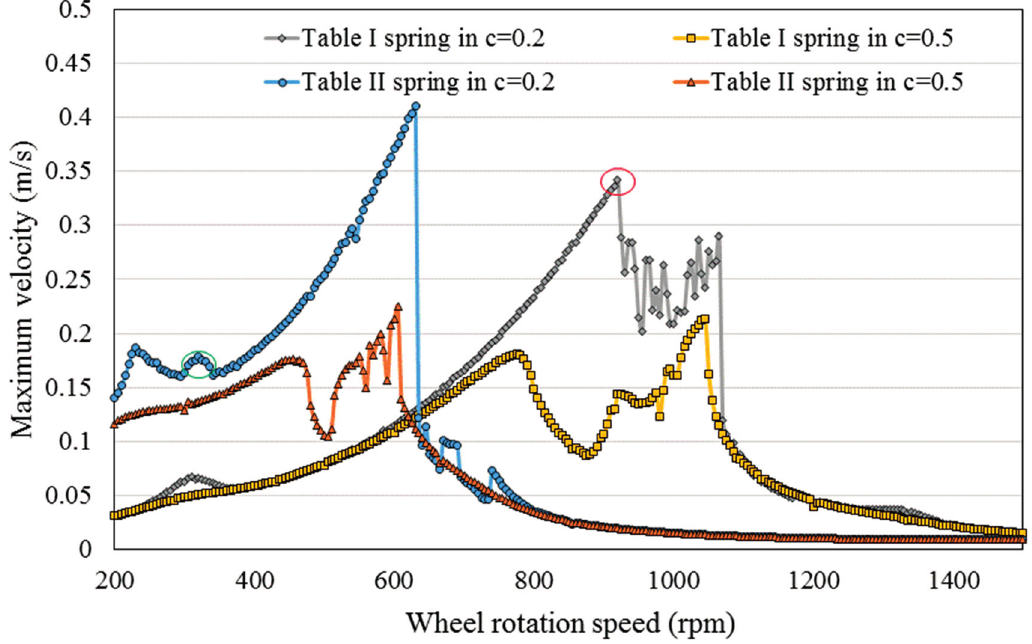
Figure 7. Frequency domain characteristics of NSEHs (of Tables 1 and